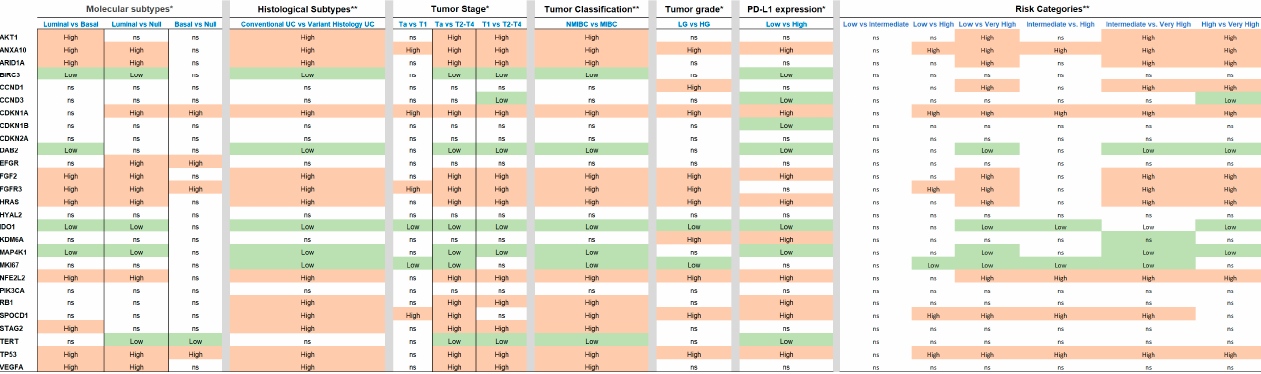
Table 3. Cancer-speci fi c survival-related gene expression signature. Gene